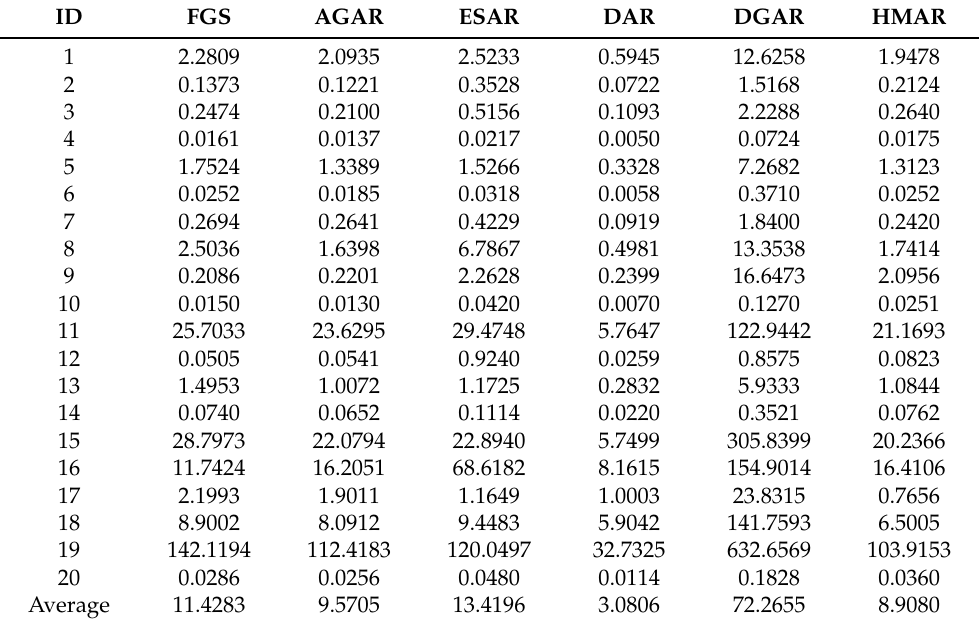
Table 5. The elapsed time of obtaining the reducts (seconds).